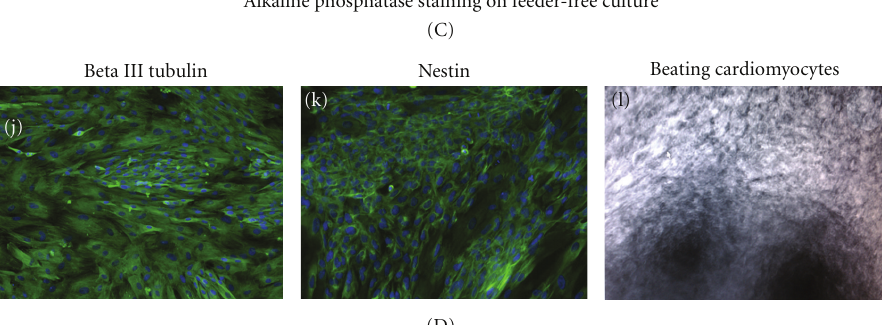
Figure 2: (A) Characterization and di ff erentiation of iPSC colonies generated on feeder-free conditions. Colonies were stained for pluripotent markers: SSEA4 (b), SOX2 (c), Tra1-81 (e), NANOG (f), and phase ((a) and (d)). (B) These colonies were di ff erentiated in vitro into embryoid bodies (EBs) comprising of the three embryonic germ layers: endoderm marker α fetoprotein (AFP) (g), mesodermal marker smooth muscle actin (SMA) (h), and ectoderm marker Beta 3-tubulin (Beta III) (i). (C) Colonies were stained with alkaline phosphatase staining 25 days after transduction. (D) Colonies were also subjected to directed di ff erentiation to neural stem cells, stained with Beta 3- tubulin (Beta III) (j), Nestin (k), and random di ff erentiation to beating cardiomyocytes